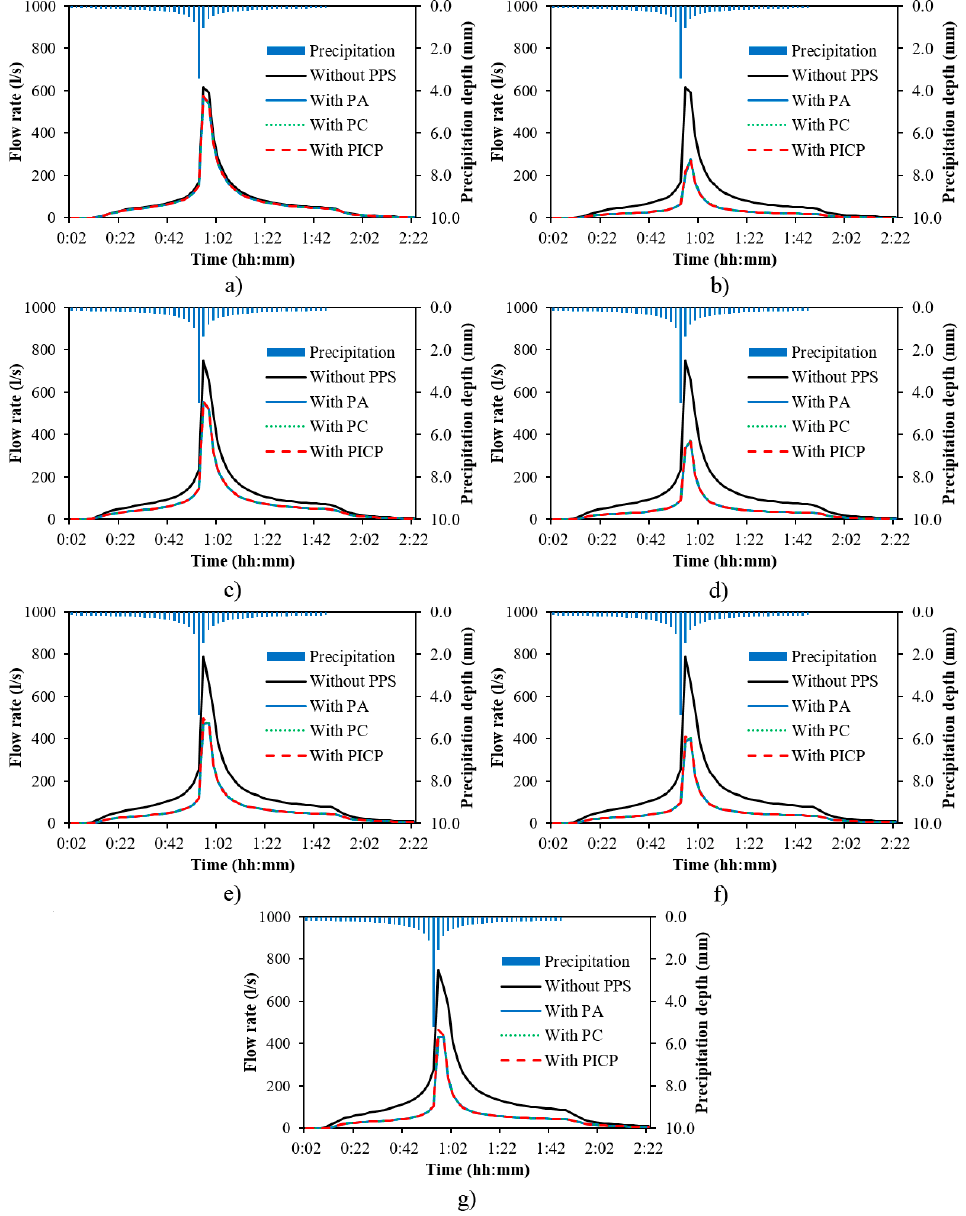
Figure 8. Hydrographs at the outlet of the study catchment for different climate scenarios and return periods (T), without and with Permeable Pavement Systems (PPS): ( a ) RCP4.5; T = 2 years; Min; ( b ) RCP4.5; T = 2 years; All; ( c ) RCP8.5; T = 2 years; Min; ( d ) RCP8.5; T = 2 years; All; ( e ) RCP4.5; T = 10 years; Min; ( f ) RCP4.5; T = 10 years; Min; and ( g ) stationary; T = 50 years; Min/All.